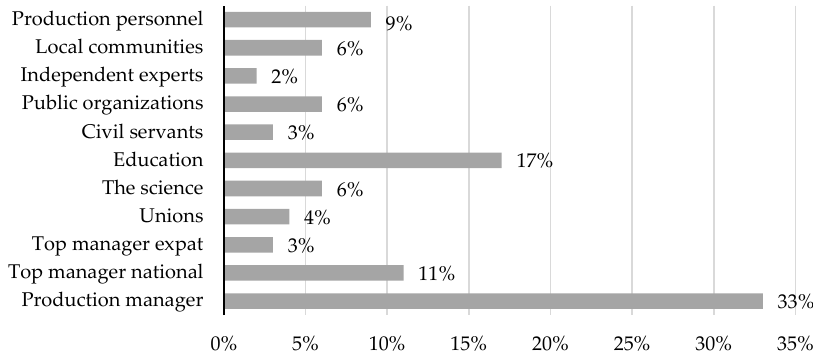
Figure 2. Expert categories by fields of activity.